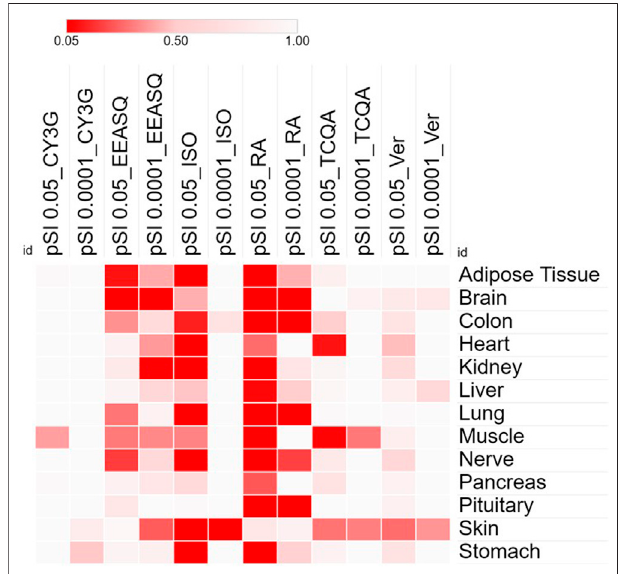
FIGURE 1 | Heat map showing the signi fi cance and speci fi city of the tissue expressions by the differentially expressed genes of different compounds in hAESCs. Cells were treated with compounds for 7 – 10 days and RNAs were isolated from the control and treated hAESCs for microarray experiments using the Affymetrix ’ s GeneAtlas ® System (Affymetrix Inc., Santa Clara, CA, USA, human genome array strips; HG-U219). Genes with a linear fold change > 1.1 (verbenalin), 1.2 (RA, TCQA and EEASQ), and 2 (ISO, CY3G) and a p -value < 0.05 (one-way between-subjects ANOVA) were considered as differentially expressed genes. Enrichment analysis was conducted using the Tissue Speci fi c Expression Analysis (TSEA) tool (http:// genetics.wustl.edu/jdlab/tsea//). Heat map was generated on Morpheus tool (https://software.broadinstitute.org/morpheus//). Signi fi cance of tissue enrichment were identi fi ed by Fisher ’ s Exact test. pSI, Speci fi city Index thresholds; pSI 0.05, signi fi cantly enriched all transcripts; pSI 0.0001, most speci fi c subset of signi fi cantly enriched transcripts; CY3G, cyanidin 3- glucoside; EEASQ, ethanol extract of Aurantiochytrium-derived